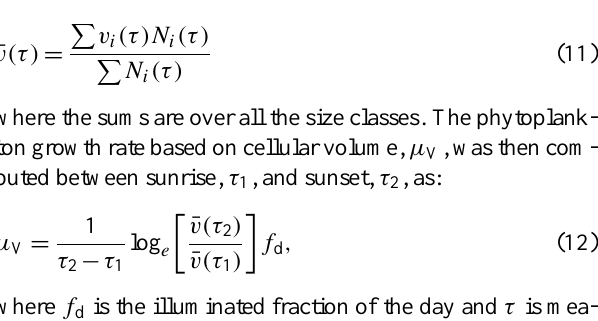
(Fig. 3). Estimates of model parameters for three different values of the refractive index are presented in Table 3. The relative uncertainties of the parameters were typically below 24 %. Most parameters were independent of the refractive index, which suggests that they can be estimated accurately, provided the model assumptions are correct. On the other hand, the estimates of D min and v nb0 depended on the value of m selected for the optimization (Table 3), as did the pop- ulation time- and size-average diameter and total number of cells (Table 4). These parameters therefore cannot be esti- mated independently of m (see also Discussion